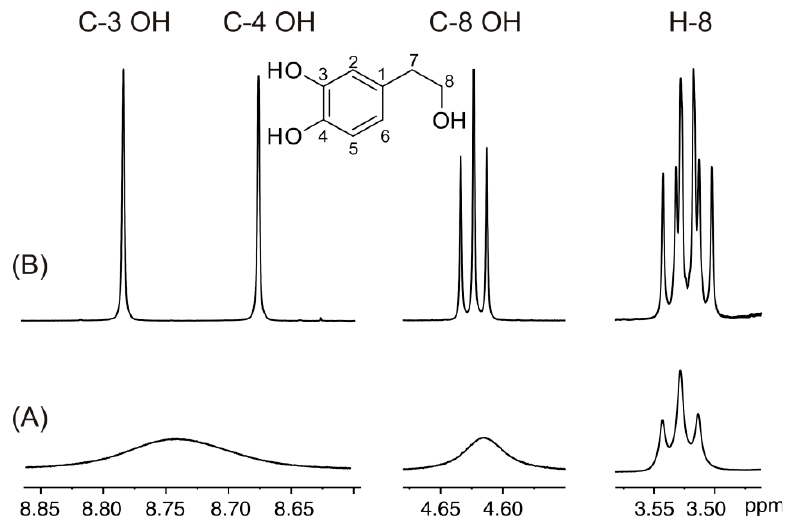
Figure 6. 500 MHz 1D 1 H-NMR spectra of hydroxytyrosol (C = 19.6 × 10 − 3 M, T = 288 K, number of scans = 16), in ( A ) DMSO- d ; ( B ) with a molar ratio of [picric 6 acid]/[hydroxytyrosol] of 1.3 × 10 − 3 . Reproduced with permission from [16]. Copyright 2011, by the American Chemical Society.